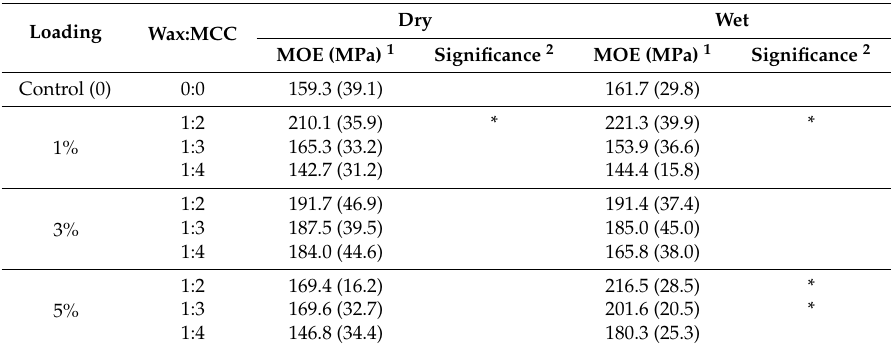
Table 1. The flexure moduli of epoxy and EMC/epoxy composites before (dry) and after (wet) immersion in distilled water for 24